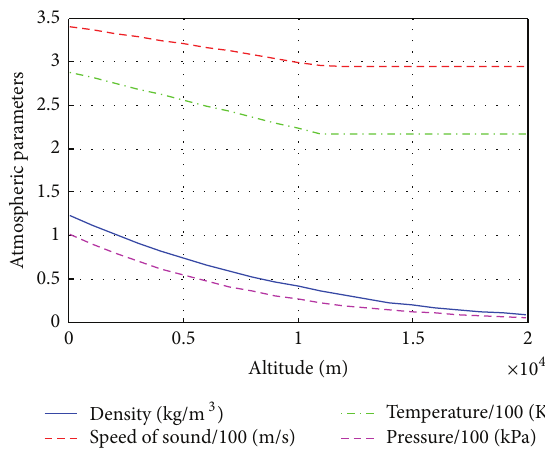
Figure 3: Atmospheric parameters versus altitude.